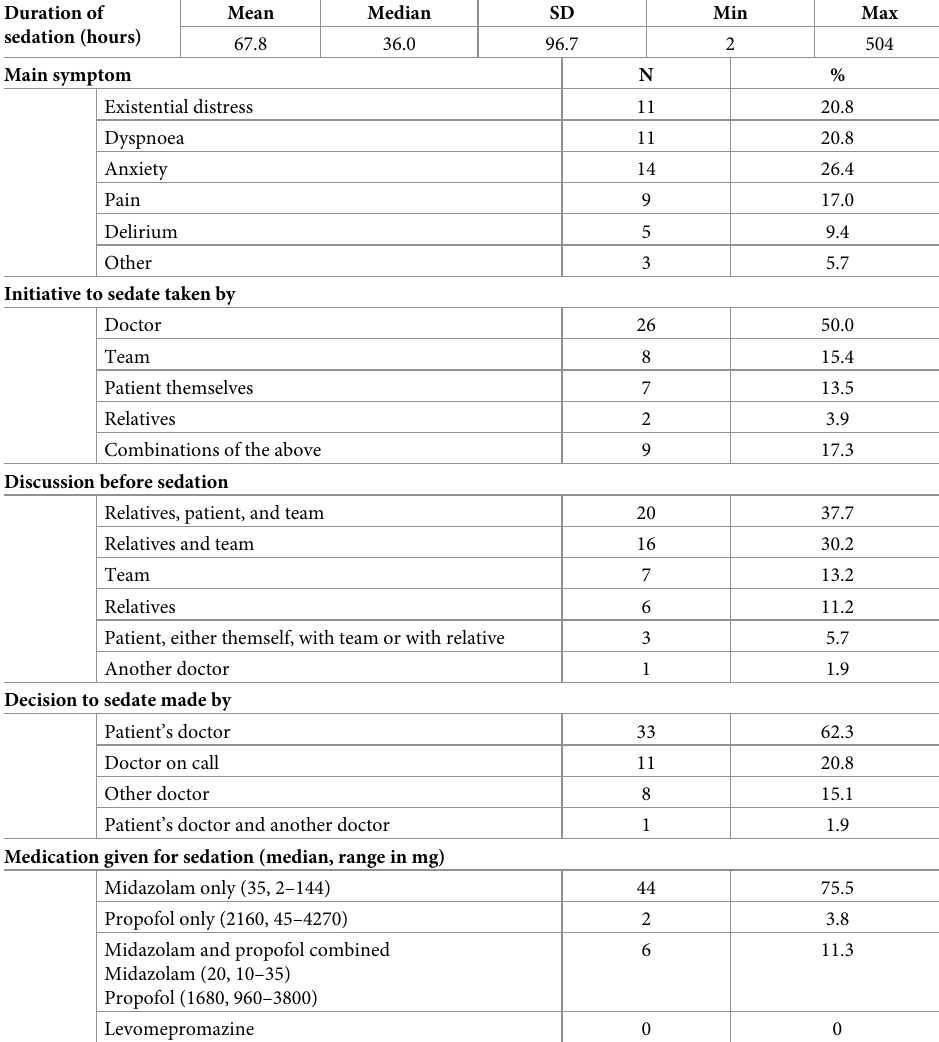
Table 3. Characteristics of patients with palliative